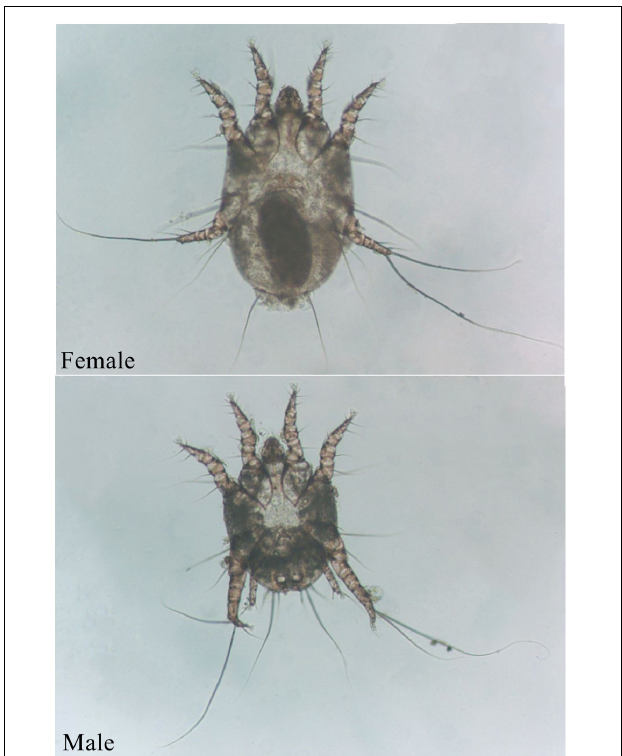
FIGURE 1 | Adult O. cynotis